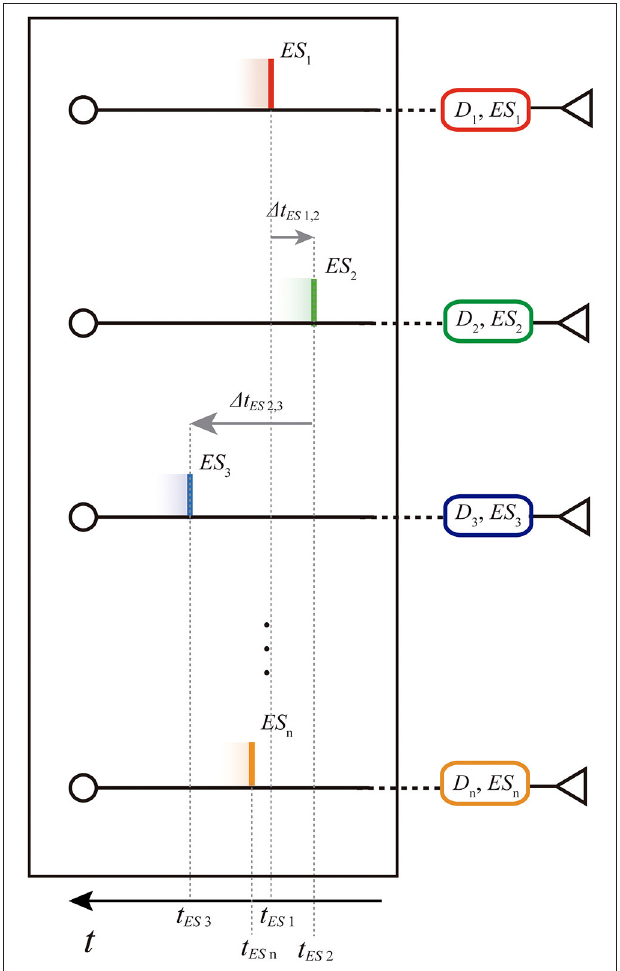
FIGURE 3 | Representation of the spike train shown in Figure 2 on the entryway of the structure: absolute spike times ( t ES 1 , t ES 2 ,..., t ESn ) and relative intervals ( 1 t ES 1,2 , 1 t ES 2,3 ,..., 1 t ESn − 1, n ). Note that the time axis is reversed since we are representing the parallel spike train in motion toward right.